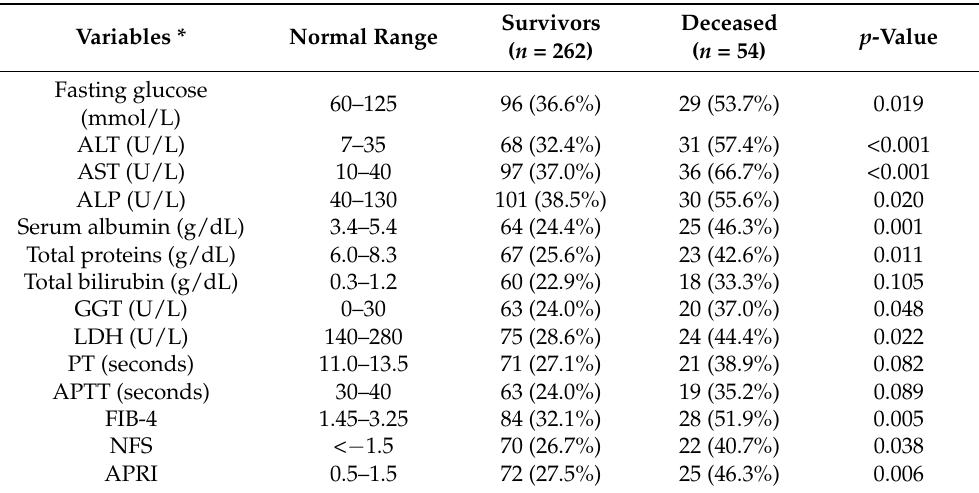
Table 5. Comparison of liver studies at admission between survivors and deceased elderly with COVID-19.